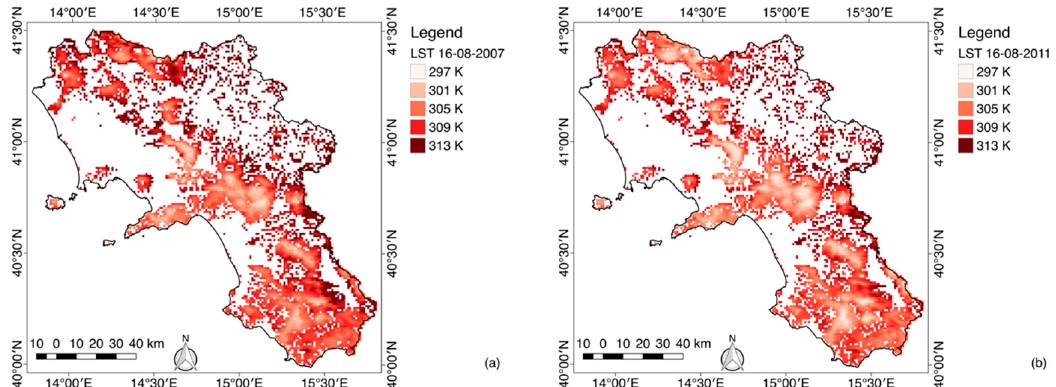
Figure 3. Sample maps of LST as derived from HANTS processing of annual time series in vegetated and recently burned areas (land cover classes in Table 1): 16 August 2007 ( a ); 16 August 2011 ( b ).